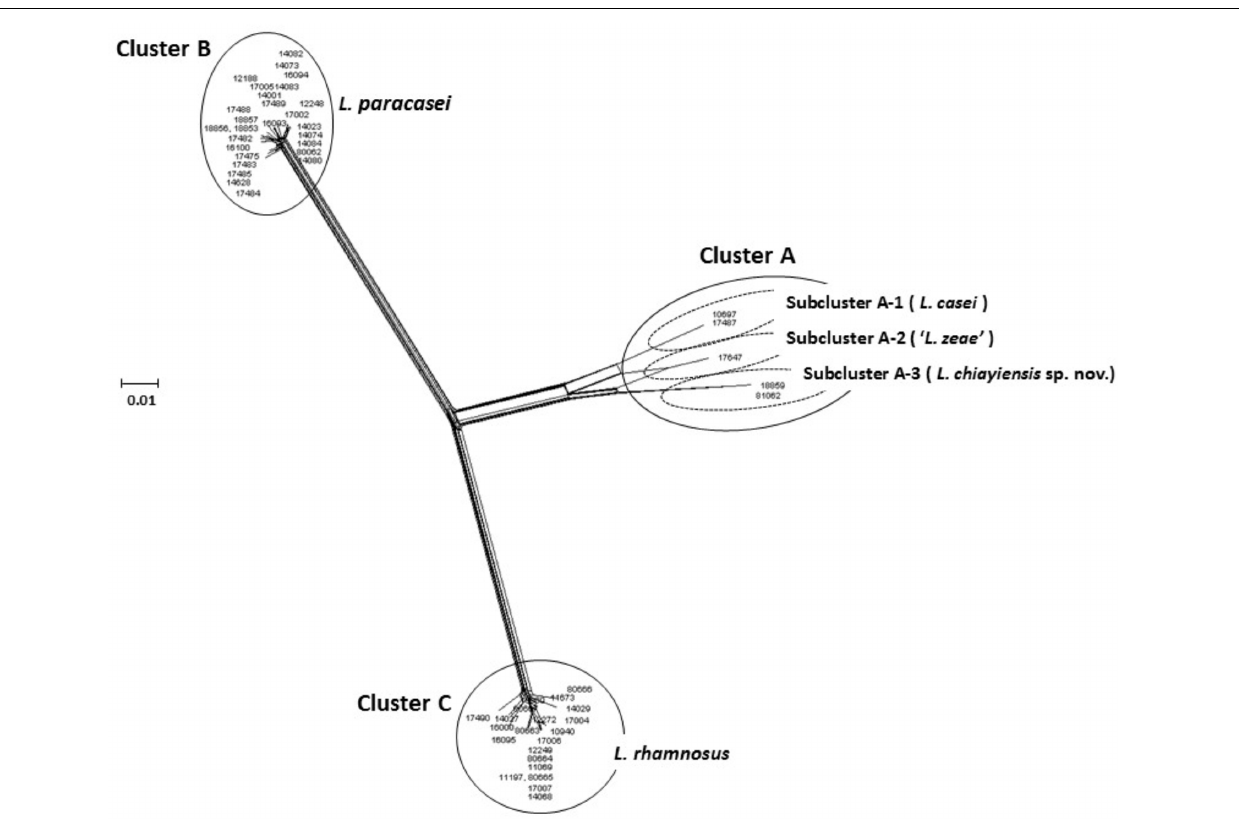
FIGURE 1 | Concatenated split network tree based on five genes. The dnaJ , dnaK , mutL , pheS , and yycH gene sequences (2567 bp) from 53 L. casei group strains were concatenated and reconstructed using the SplitTree4 program. Sequence similarities were corrected using the Jukes-Cantor correction. Bar, 0.01 expected nucleotide substitutions per